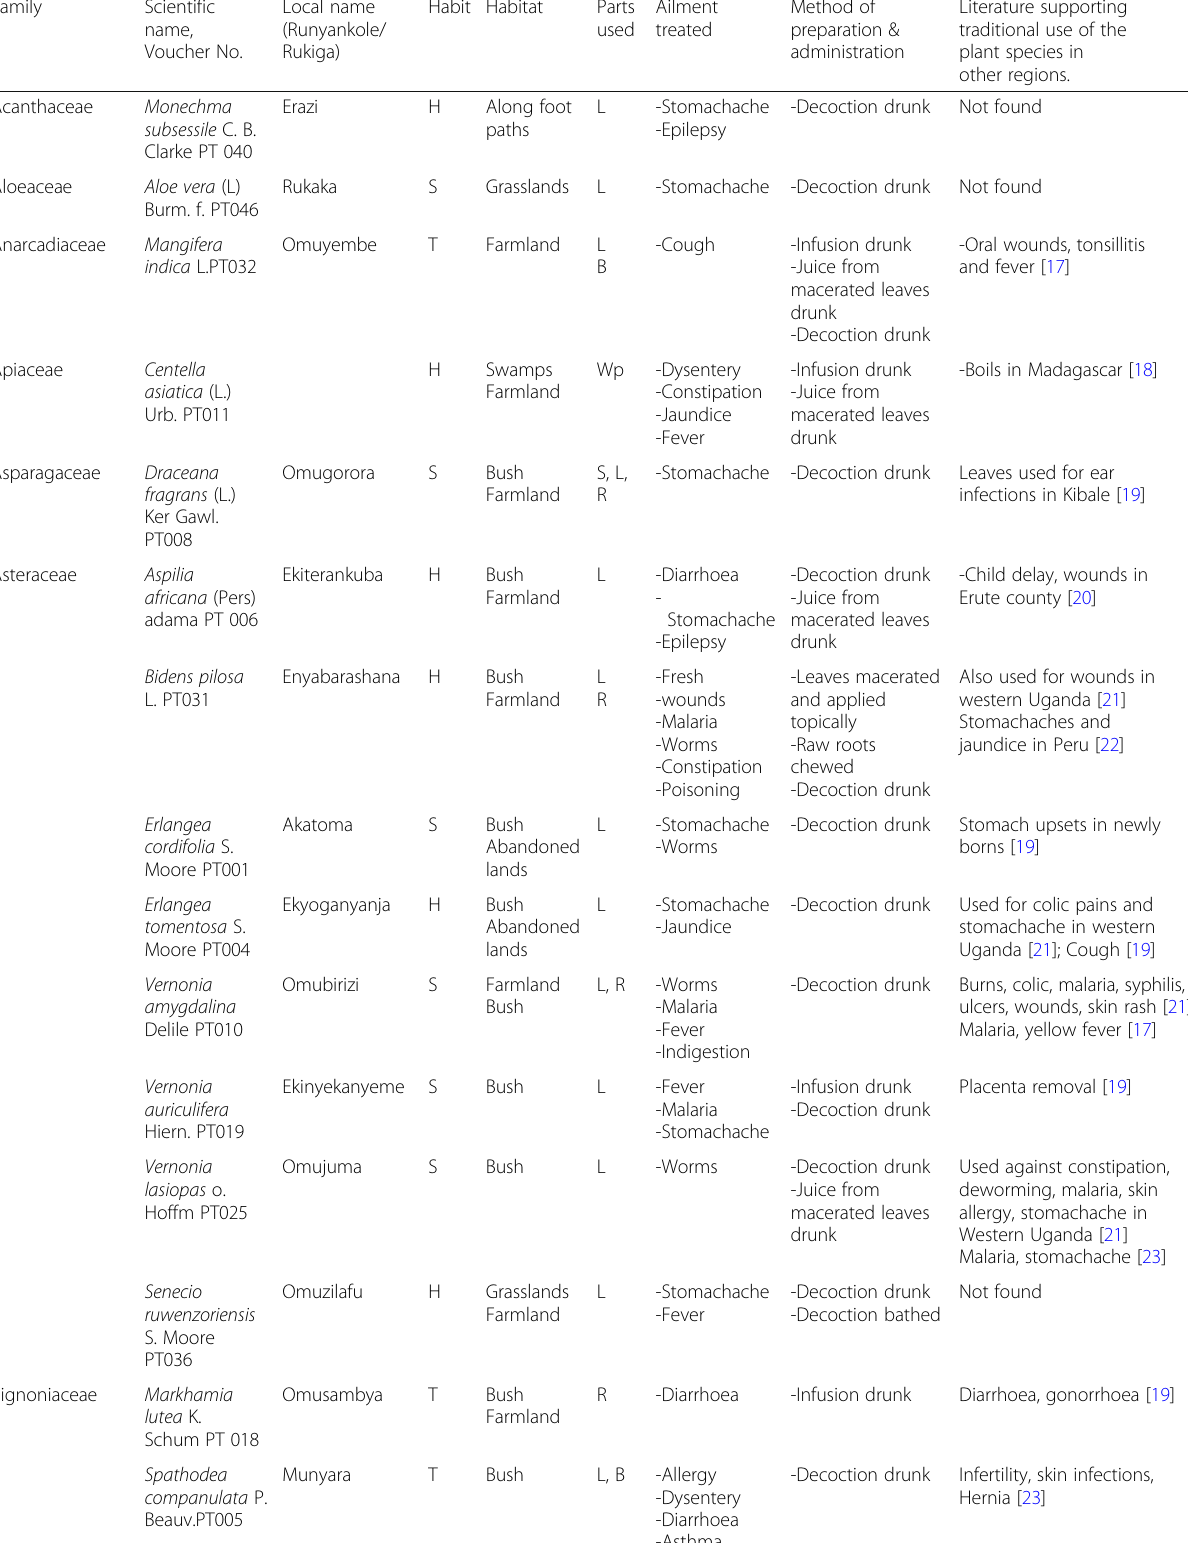
Table 1 Medicinal plant species, their habit, habitat, parts used, ailments treated, mode of preparation and administration